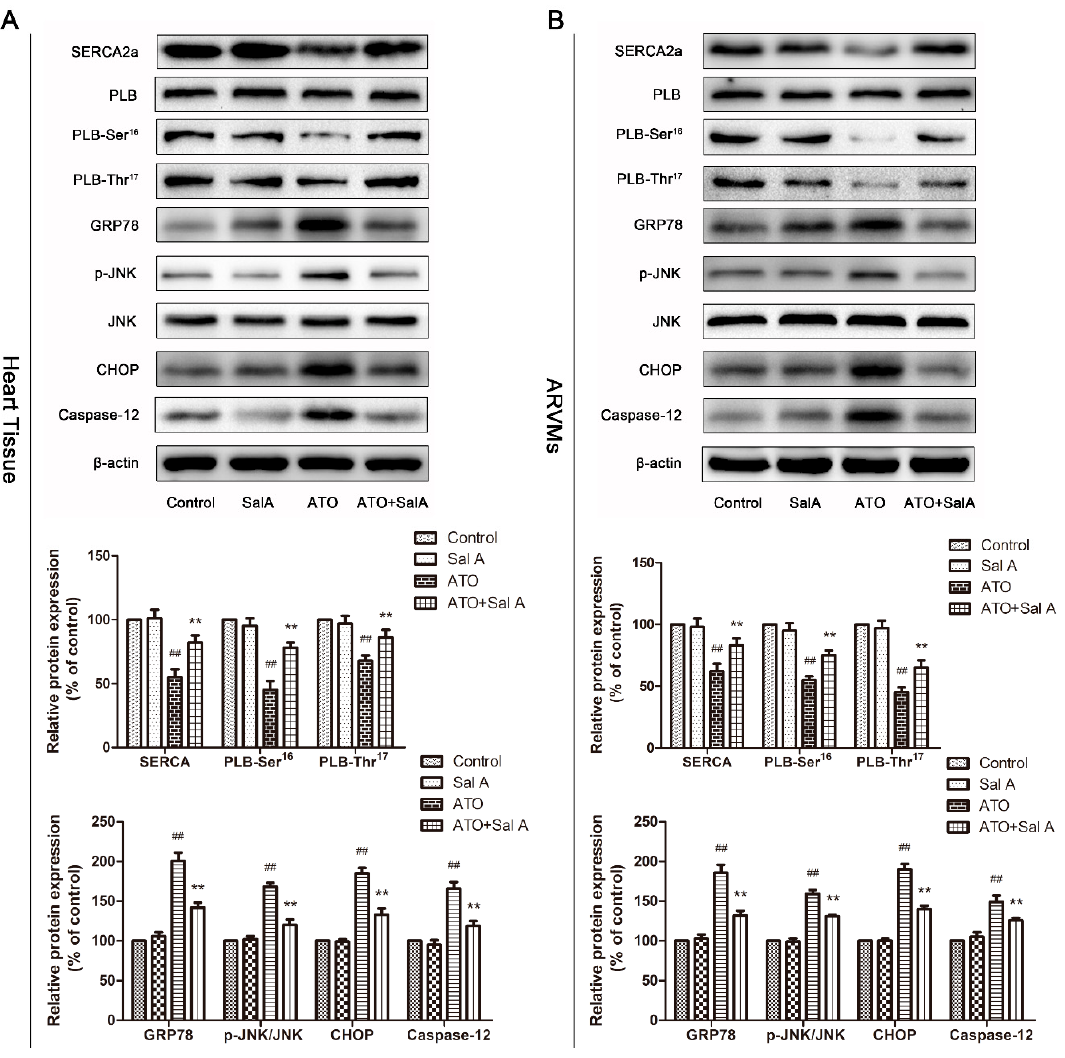
Figure 7. Sal A regulated Ca 2+ -handling and endoplasmic reticulum (ER) stress-related protein expression after ATO treatment. ( A ) Ca 2+ -handling and ER stress-related protein expression in mice heart tissue and ( B ) in ARVMs. All data are expressed as the mean ± SD; ## p < 0.01 vs. control, ** p < 0.01 vs. ATO.